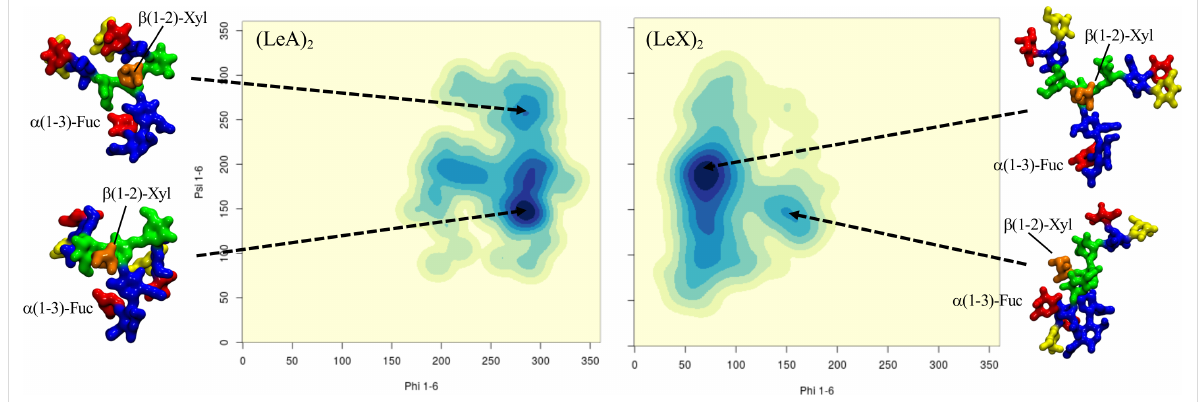
Figure 4: Comparison of the different conformational equilibria of the (1-6) arm in a core α (1-3)-Fuc β (1-2)-Xyl A2 N-glycan with terminal LeA and LeX groups on the left- and right-hand side, respectively. Representative structures from 1.5 μ s MD sampling of each system are shown to illustrate the conformations corresponding to the different minima. The N-glycans structures are shown with the (1-3) and (1-6) arms on the left and on the right, re- spectively. The monosaccharides colouring follows the SFNG nomenclature. The structure rendering was done with VMD (https://www.ks.uiuc.edu/ Research/vmd/) and the graphical statistical analysis with RStudio